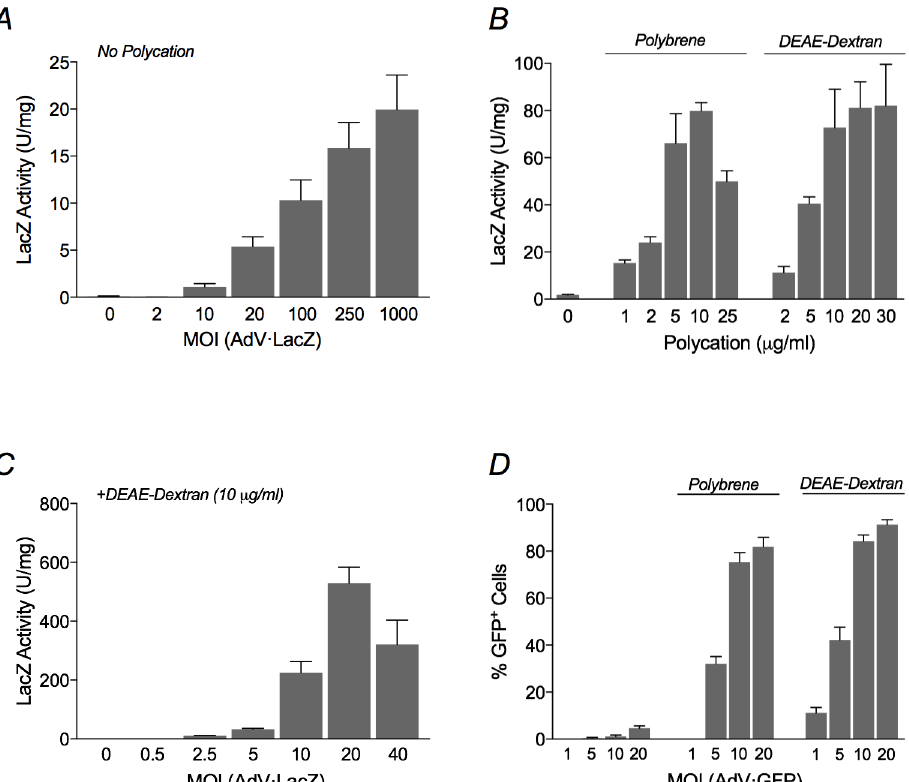
Fig 1. Enhancement of adenoviral transduction by polycations. C3H10T1/2 cells were transduced with recombinant adenoviruses expressing LacZ (AdV (cid:1) LacZ) or GFP (AdV (cid:1) GFP) in the presence or absence of polycations. (A) Cells were transduced with AdV (cid:1) LacZ at the indicated MOIs in the absence of polycation. The cells were lysed 2 days later, and LacZ activity was measured. Activity is expressed as units per mg cell lysate. The data are averages of three different experiments, each carried out in triplicate, ± SEM; p < 0 .05 for MOIs (cid:21) 20 relative to no virus. (B) Cells were transduced with AdV (cid:1) LacZ at an MOI of 10 at the indicated concentrations of polybrene and DEAE-dextran. The cells were lysed 2 days later, and LacZ activity was measured. The data are from an individual experiment that represents three experiments total, each carried out in triplicate but using slightly different sets of concentrations of polycations, ± SEM; p < 0.01 at all concentrations of polycation relative to no polycation. (C) Cells were transduced with AdV (cid:1) LacZ at the indicated MOIs in the presence of 10 μ g/ml DEAE-Dextran. The cells were lysed 2 days later, and LacZ activity was measured. The data are averages of four different experiments, each carried out in triplicate, ± SEM; p < 0.05 for MOIs (cid:21) 2.5 relative to no virus. (D) Cells were transduced with AdV (cid:1) GFP at the indicated MOIs without or with polybrene (5 μ g/ml) or DEAE-dextran (10 μ g/ml). The cells were fixed 2 days later, counterstained with DAPI, and evaluated as the number of GFP- relative to DAPI-positive cells by fluorescence microscopy. The data are from an individual experiment that represents three experiments total, each carried out using a minimum of 10 random fields for each data point, but using slightly different sets of concentrations of polycations, ± SEM; p < 0.01 for MOIs (cid:21) 5 in the presence of polycation relative to absence of